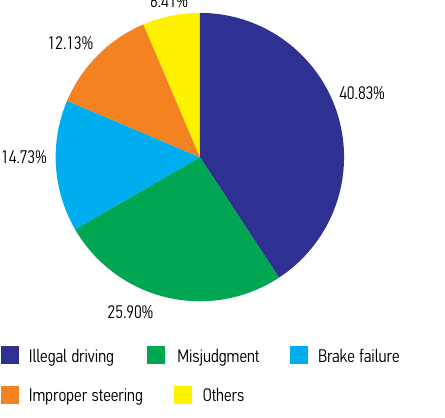
Fig. 5. Average posterior probabilities of human factors